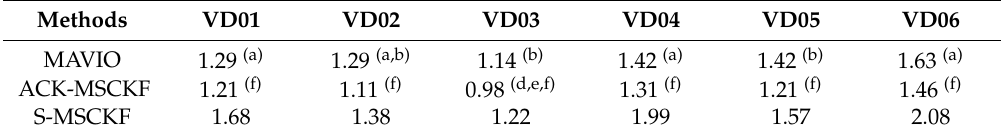
Table 4. The average root mean square scale ratio (RMSSR) at the last time step on each experimental dataset.